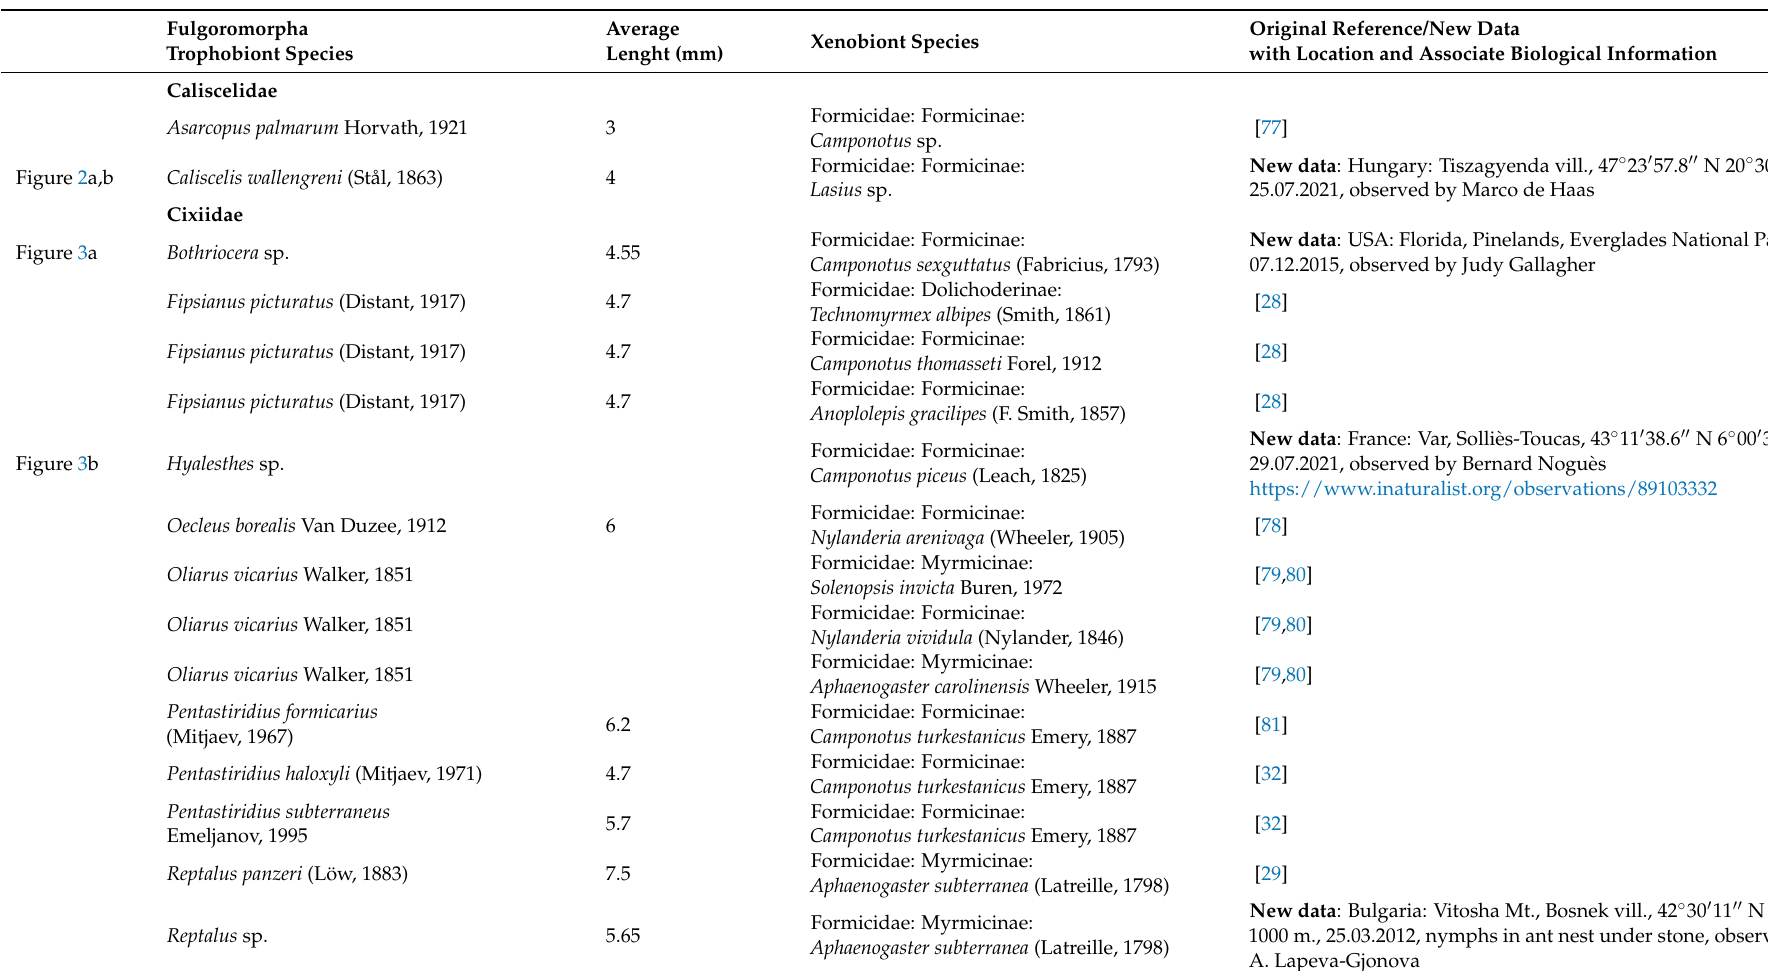
New data : USA: Florida, Pinelands, Everglades National Park, Homestead, 07.12.2015, observed by Judy Gallagher